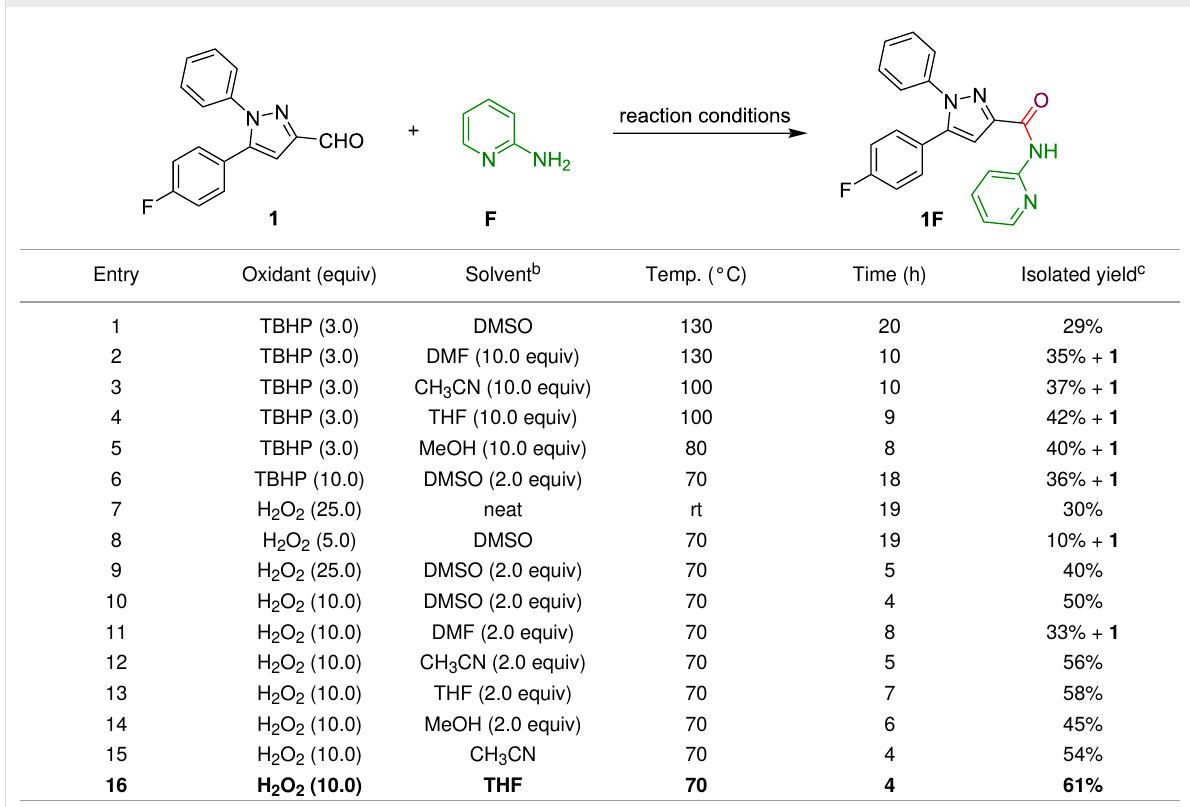
Table 2: Optimization of the reaction conditions towards the formation of pyrazole-pyridine conjugates having an amide linkage.